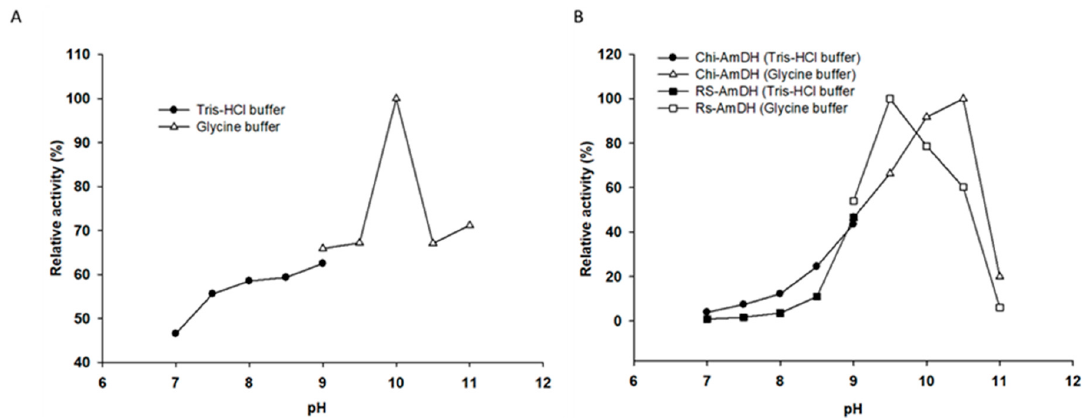
Figure 3. Effect of pH on the activity of ( A ) AlaDH; ( B ) Chi-AmDH; and Rs-AmDH. Reactions conditions: For AmDH assay: 10 mM rac- a7 (rac- a3 -for Rs-AmDH), 1 mM NAD + , 0.2 mg / mL conditions: For AmDH assay: 10 mM rac- a7 ( rac- a3 -for Rs-AmDH ) , 1 mM NAD + , 0.2 mg/mL AmDH, 100 mM Tris/HCl buffer (pH 7.0–9.0), 100 mM Glycine buffer (pH 9.0–11.0); For AlaDH assay: 10 mM pyruvate, 1 mM NADH, 0.2 mg/mL AlaDH, 100 mM Tris/HCl (pH 7.0–9.0), 100 mM Glycine buffer (pH 9.0–11.0).